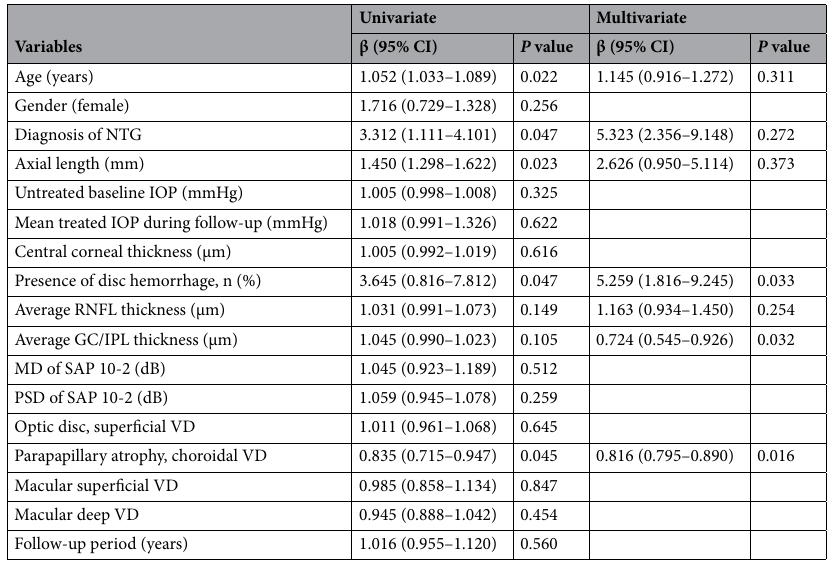
Table 3. Associated risk factors to 10-2 VF progression in glaucoma patients. NTG, normal-tension glaucoma; IOP, intraocular pressure; RNFL, retinal nerve fiber layer; GC/IPL, ganglion cell/inner plexiform layer; MD, mean deviation; PSD, pattern standard deviation; VD, vessel density. Variables with P < 0.2 were entered in the multivariate analysis.